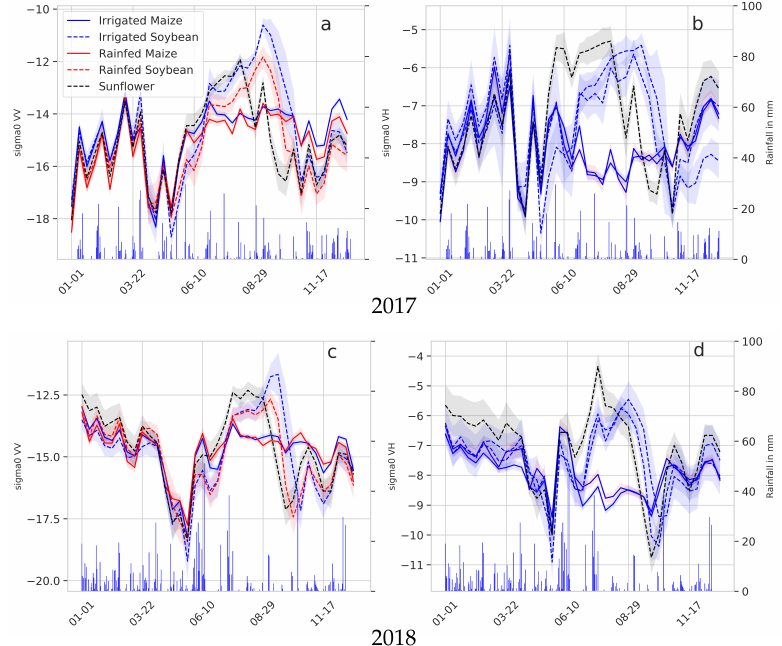
Figure 4. Dynamics of SAR polarisations (VV ( a , c ) and VH ( b , d )) for maize, soybean and sunflower crops, The solid line curves represent maize, the dotted line represents soybean, with irrigated blue and rainfed red for both crops. The black curve represents sunflower. The envelope around the curves corresponds to the 95% confidence